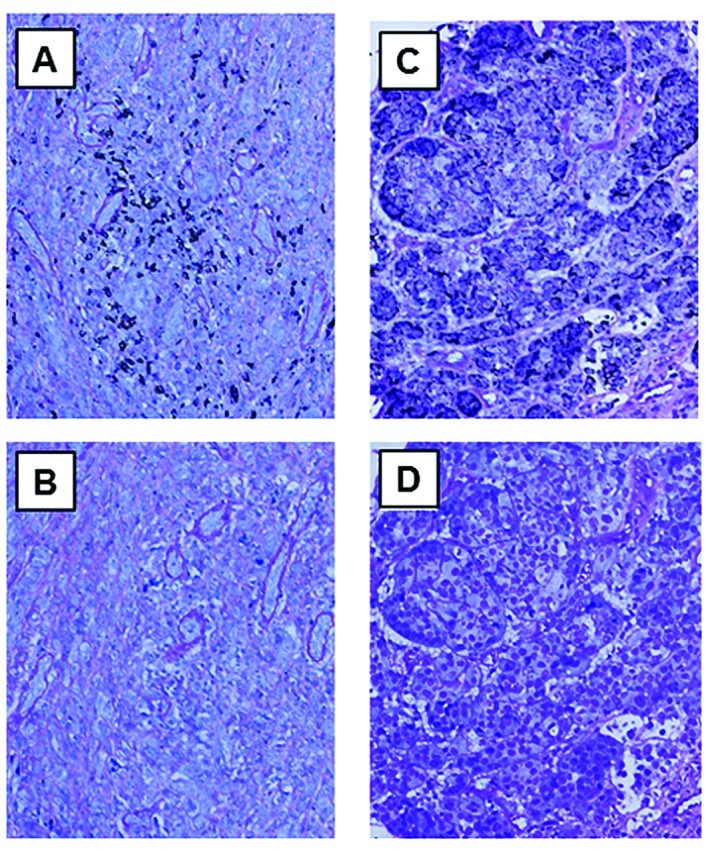
Immunohistochemical analysis of CD8 and IL-17 expression in melanoma tumors. (A) and (B) tumor tissue from MEL-2; (C) and (D) tumor tissue from MEL-11. (A) CD8 staining, (C) IL-17 staining, (B) and (D) isotype control antibody staining. The counter-staining was performed with the Giemsa stain. Magnification, ×100.